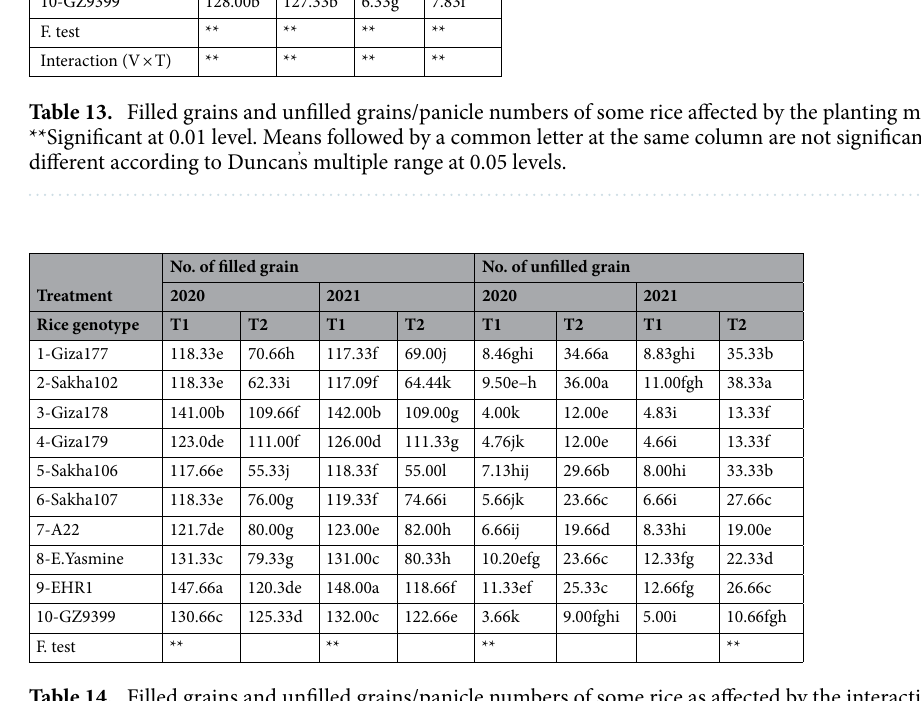
Table 14. Filled grains and unfilled grains/panicle numbers of some rice as affected by the interaction. T1 = Transplanting, T2 = Aerobic, **Significant at 0.01 level. Means followed by a common letter at the same column are not significantly different according to Duncan ’ s multiple range at 0.05 levels.